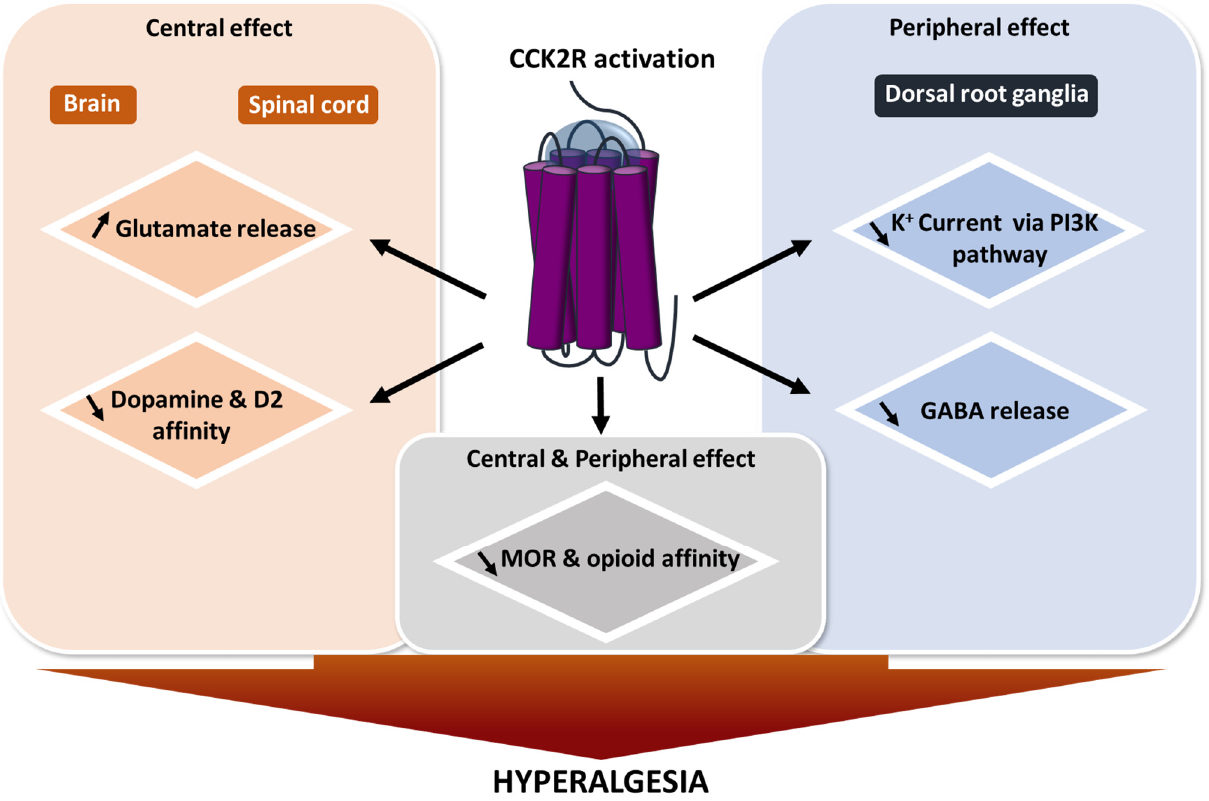
Figure 2. Effect of CCK2R activation on pain modulation. Summary of known CCK2R actions after activation. Most of its interactions induce a mechanism leading to hyperalgesia. GABA: gamma-aminobutyric acid; D2: dopamine receptor 2; MOR: µ opioid receptor; PI3K pathway: Phosphoinositide 3-kinase pathway.